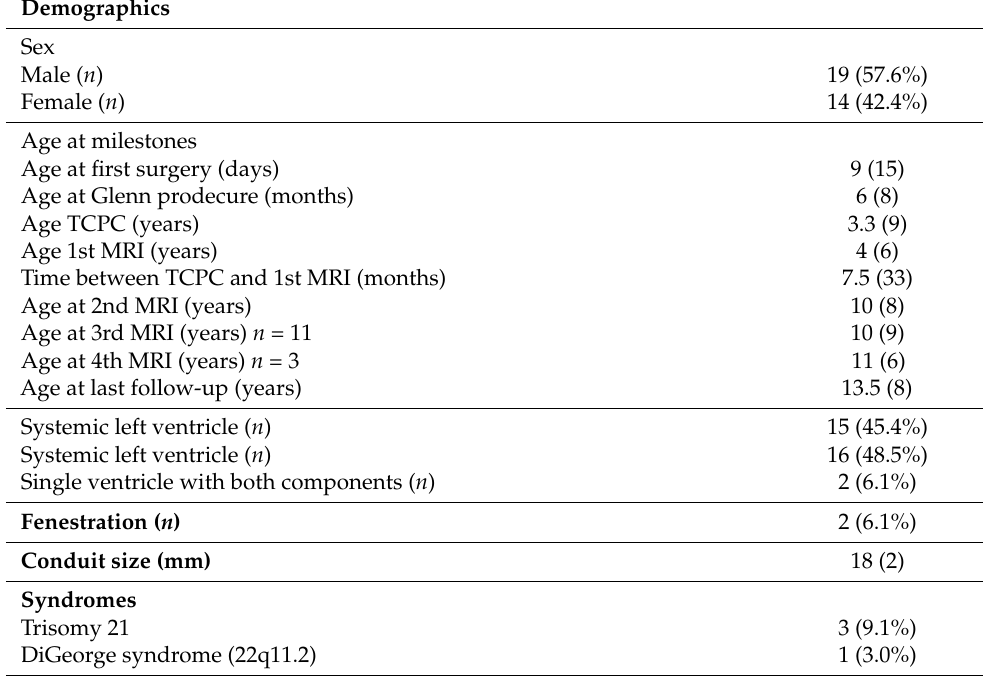
Table 1. Demographics and clinical characteristics of study